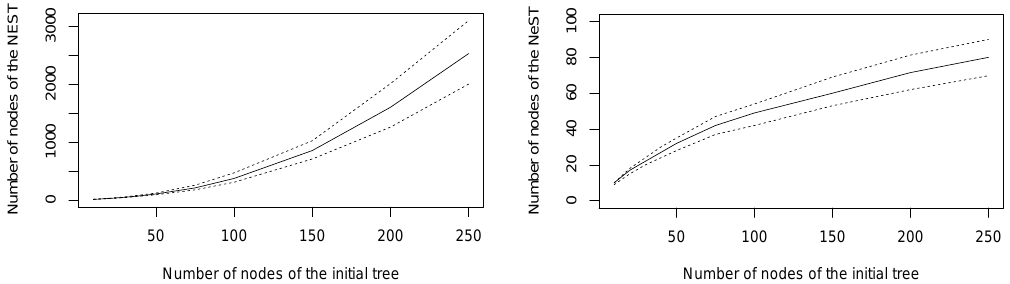
Figure 9. Number of nodes of the NEST ( left ) and of the NeST ( right ) estimated from 3000 random trees: average (full lines) and first and third quartiles (dashed lines).